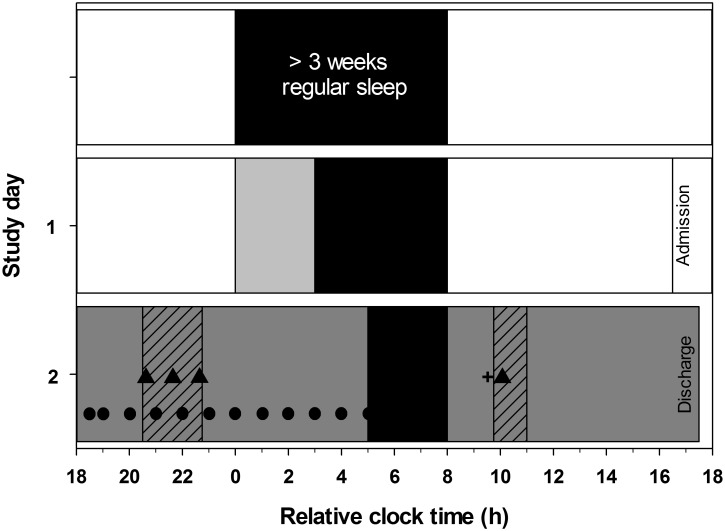
Study protocol to assess sleepiness following sleep restriction.The protocol is plotted for a participant maintaining a 00:00–08:00 h sleep schedule (black bars). Following at least 3 weeks of an 8-hour sleep schedule at home, participants restricted their sleep to 5 hours on the last night at home, remaining in dim light for the 3 hours of extended wake (grey bar on study day 1). Participants attended the sleep laboratory on the following evening. Two hours after session start ambient light levels were reduced to < 2 lux (dark grey bar on study day 2). Saliva samples (●) were collected every 30 to 60 minutes for assessment of circadian phase. Sleep was further restricted to three hours duration in the laboratory (0 lux). POMS-Bi (+) was completed 1.75 hours after waking. Two hours after waking participants underwent constant posture (grey diagonal striped bar) and completed a performance battery (▲) including the Karolinska Sleepiness Scale, auditory psychomotor vigilance test, and Karolinksa Drowsiness Test. The test battery was practiced up to three times during constant posture on study night 1.